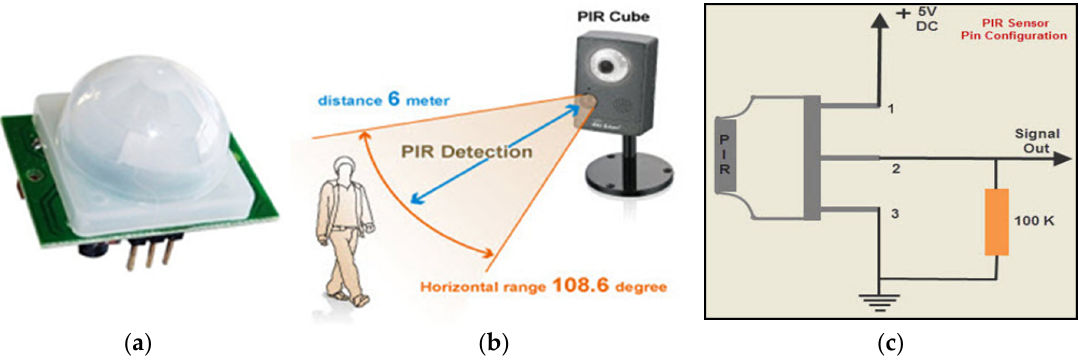
Figure 8. ( a ) PIR sensor; ( b ) working of PIR sensor; ( c ) PIR sensor circuit. (source: www.elprocus.com/pir-sensor-circuit-with-working/).